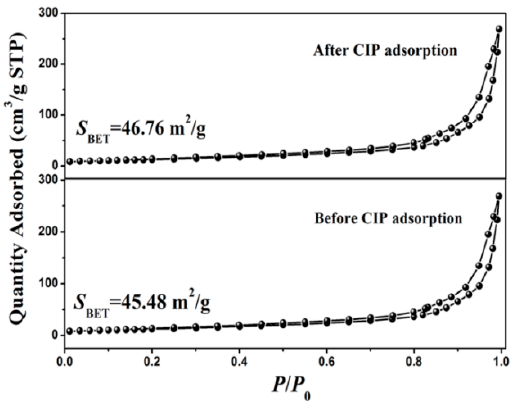
Figure 7. N 2 adsorption–desorption isotherm of HNTs before and after adsorption.